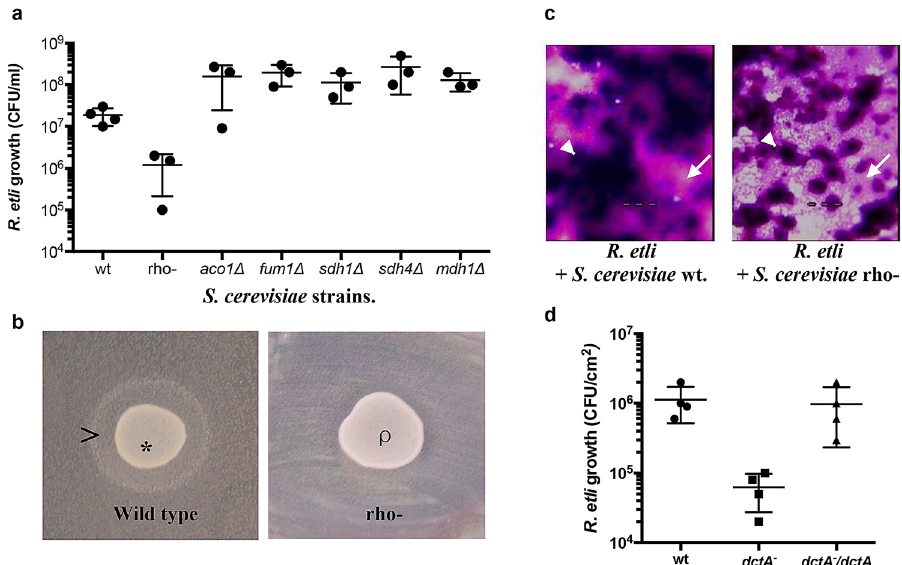
Figure 2. Yeast cells produce dicarboxylic acids that promote the growth of R. etli . ( a ) R. etli growth in coculture with S. cerevisiae BY4741 mutants ( aco1Δ , fum1Δ , sdh1Δ and mdh1Δ ) that accumulate dicarboxylic acids and a BY4741 strain with blockade of the aerobic respiratory chain (rho-). ( b ) Test on solid medium showing that S. cerevisiae BY4741 (*) secretes compounds that promote bacterial growth ( >). In